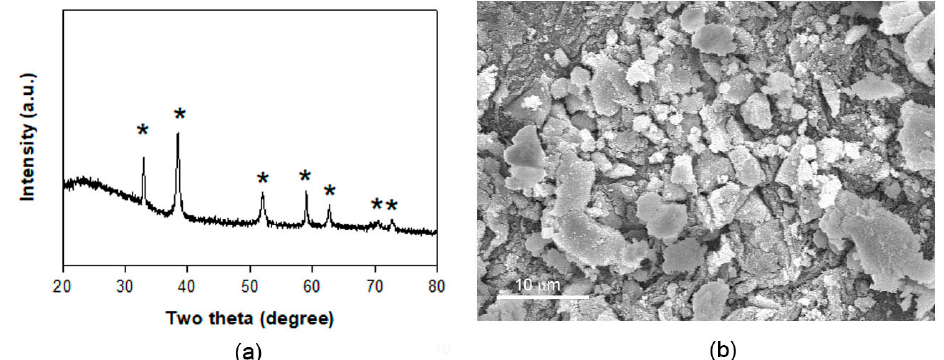
Figure 2. XRD ( a ) and SEM image ( b ) of the product formed in 200 mL of 15 M NaOH solution in the absence of EDA. Reaction duration is 8 h.